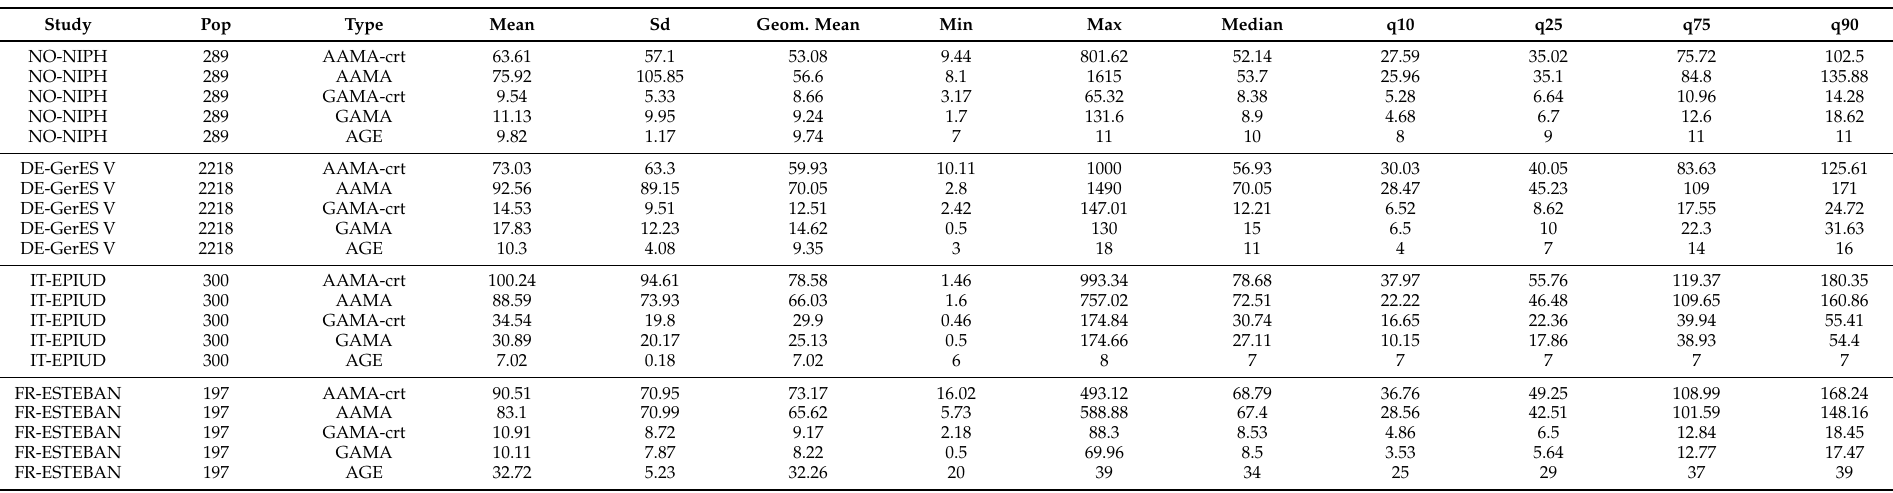
Table A4. Descriptive statistics of acrylamide biomarker levels per study (non-smoker